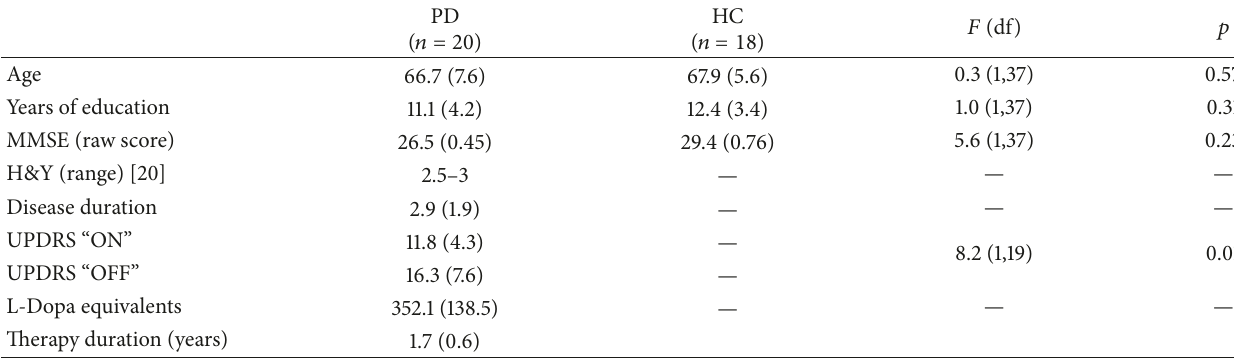
Table 1: Average (SD) of anagraphic data of experimental samples and clinical features of patient’s